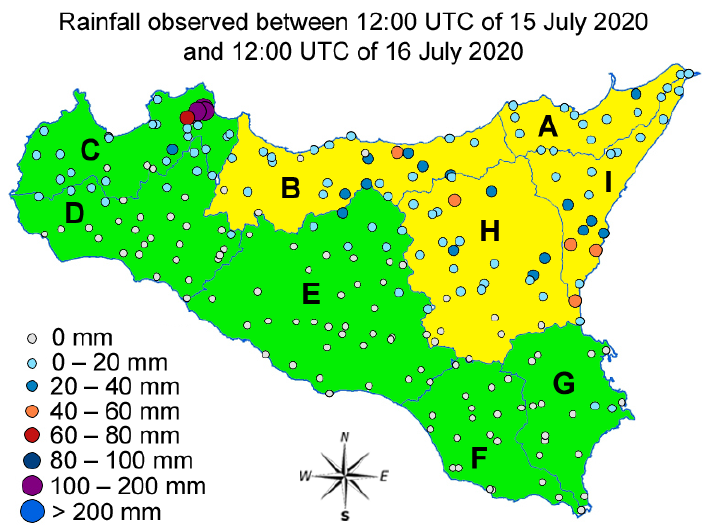
Figure 2. Rainfall accumulations recorded by the meteorological stations of the CFD-Idro Sicily (points). The alert levels of the CFD-Idro for the meteo-hydrogeological risk issued on 15 July 2020, for the different homogeneous alert zones (A, B, C, D, E, F, G, H, I), are indicated in green (criticality: absent, operational phase: generic vigilance) and yellow (criticality: ordinary, operational phase: